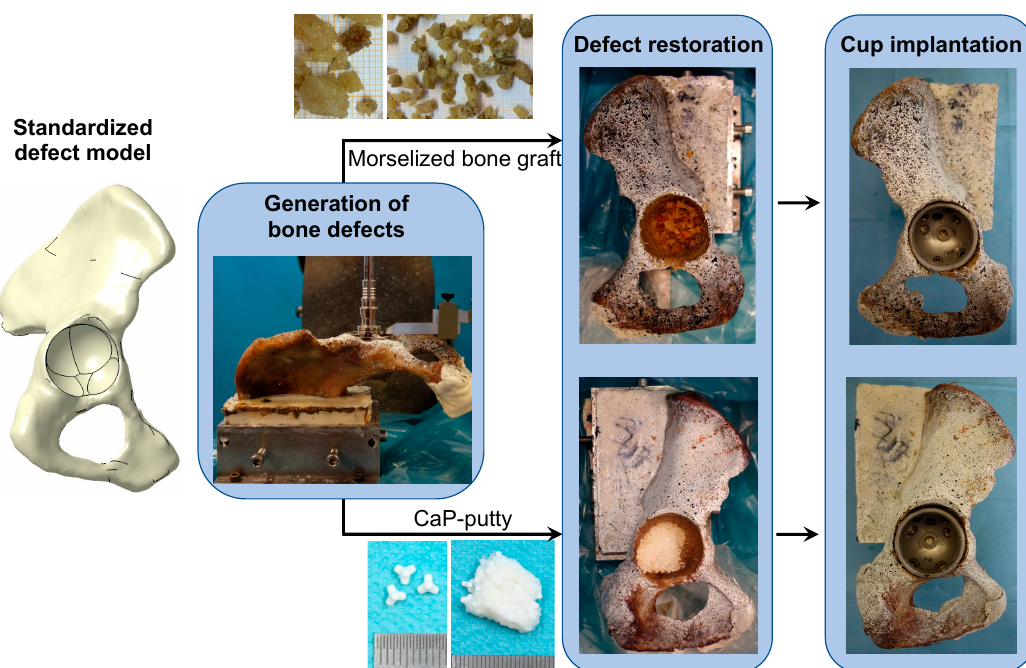
Figure 1. Preparation of the specimens: The standardized acetabular defect was implemented based on the statistical shape model developed in Schierjott et al. [21]. The hemipelvis was machined in consecutive steps using different commercial surgical reamers, with reproducible defects scaled according to the specimen-specific dimensions. Each hemipelvis and its contralateral side ( n = 10 hemipelvises in total) were alternatively reconstructed with morselized bone graft or CaP-based material. Commercial cups were press-fit in the acetabular cavity and two anchoring screws were used. Commercial cups (Plasmafit PLUS 7, Aesculap, Tuttlingen, Germany) were press fitted into the